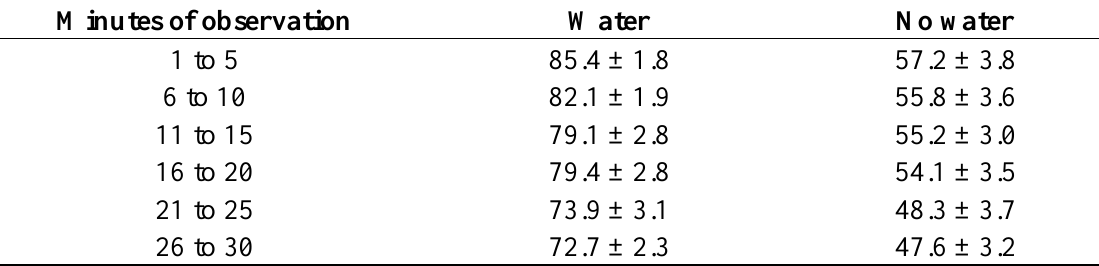
Table 1. The influence of consuming water on the percentage of time spent on task by school